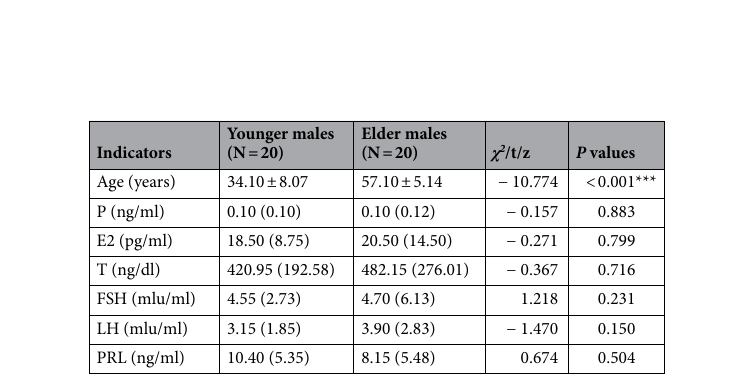
Table 4. Comparison of gonadal hormones between younger males and elder males. * P < 0.05, ** P < 0.01, *** P <